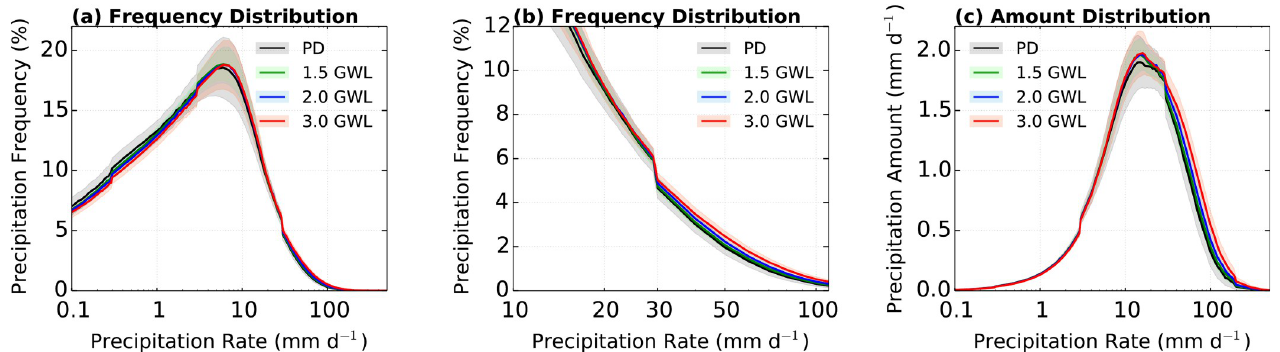
Fig 8. Same as in Fig 4 except for the PD period (black) and 1.5˚C (green), 2.0˚C (blue), and 3.0˚C (red) global warming periods. The shadings are 95% confidence in the CMIP6